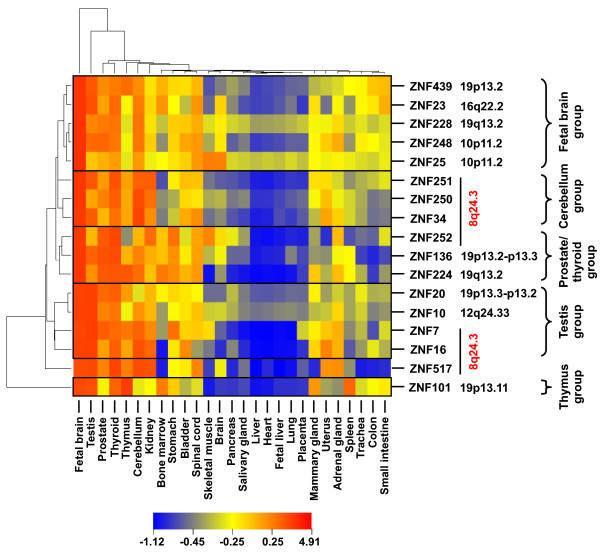
Comparison of the tissue expression patterns of the seven 8q24.3 ZNF genes and those of ten ZNF genes located on other human chromosomes by hierarchical cluster analysis. The RNA expression profiles are based on quantitative RT-PCR with total RNA from the indicated tissues as input (see Figure 7). The trees were calculated with the original relative expression data. The gene tree is based on the Pearson correlation distance and the tissue tree on Euclidian distance, both with single linkage. For the visual heatmap the data were standardized in order to fit them into the same scale, however, without changing the trees. Pseudo-color dark blue marks lowest, dark red highest expression. In addition to the gene names chromosomal localizations are indicated. The assignment of ZNF genes into tissue subgroups is based on subclades of the gene clustering and is consistent with Figure 7.